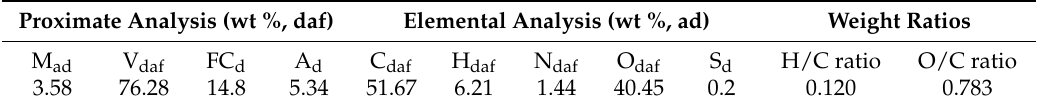
Table 1. Proximate analysis and elemental analysis 1 .